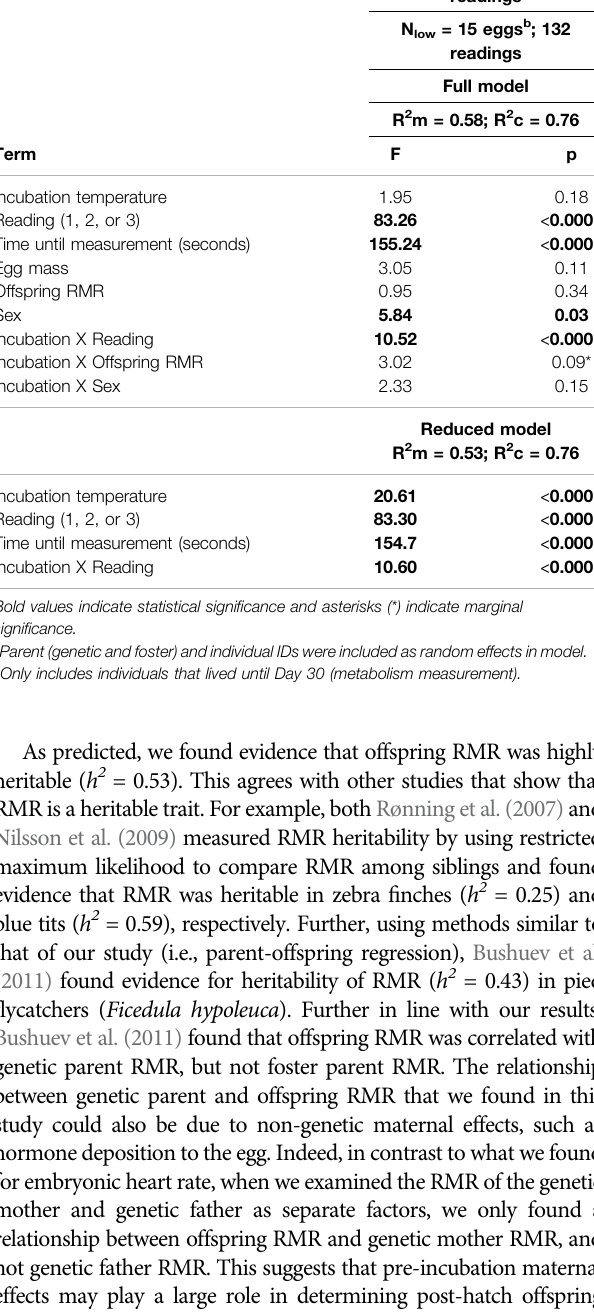
Embryonic heart rate (bpm) a N control = 20 eggs b ;163